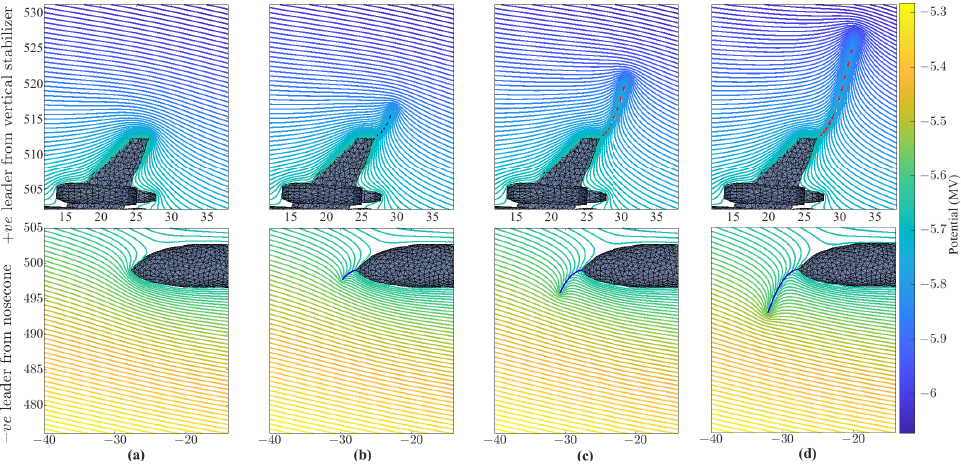
Figure 10. Equipotential plots at four different instances of bi-polar leader propagation from aircraft in Case-A of Figure 11. ( a ) Prior to discharge initiation, ( b ) − ve leader just incepted from nosecone with a step-length of 2.5 m and + ve leader length— 5 m, ( c ) + ve leader length—9.5 m and − ve leader length—4.6 m, ( d ) + ve leader length—15.7 m and − ve leader length—7.8